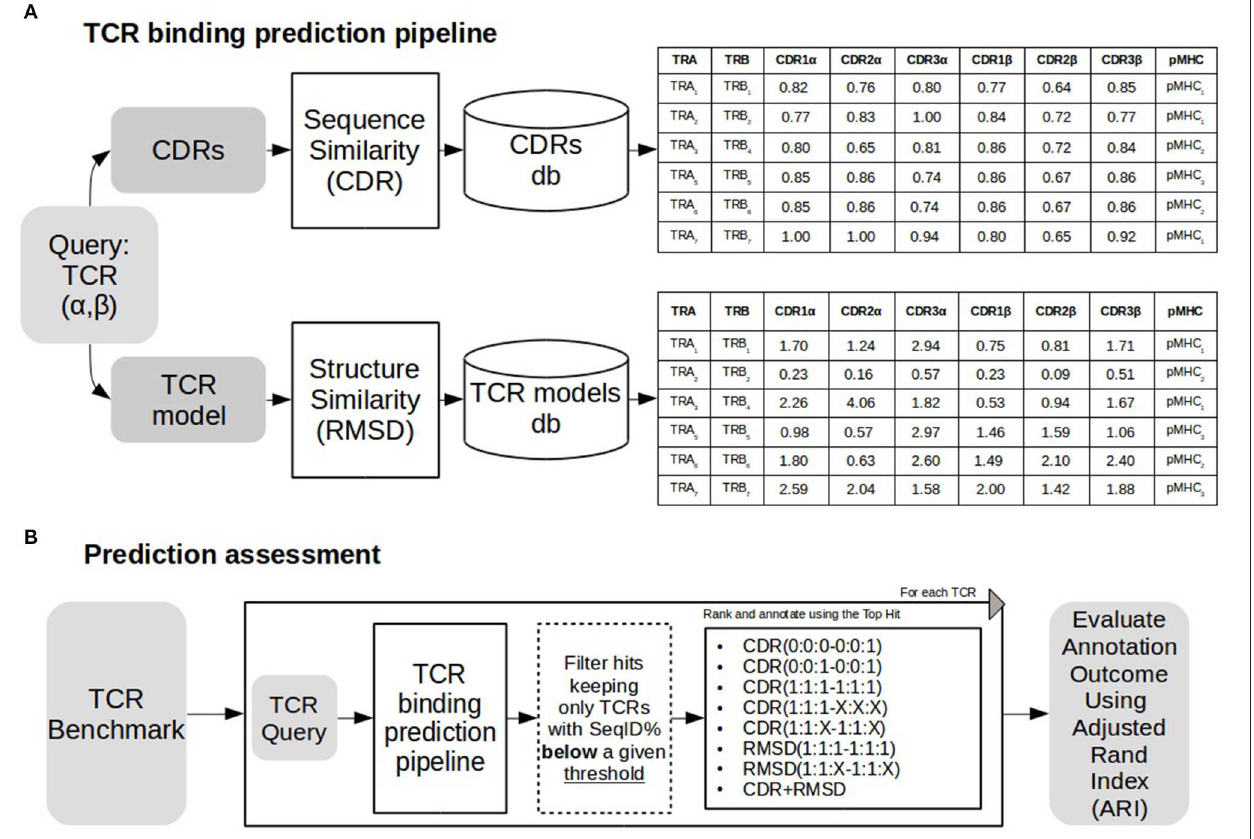
FIGURE 1 | TCR binding prediction and assessment. (A) TCR binding prediction pipeline using different similarities. A TCR query is searched against a database of CDRs of different TCRs. Similarities (CDR and RMSD) are calculated as described in methods. Sequence similarity values for each CDR loop are shown in the table above, and RMSD values for structural similarity are shown in the table below. (B) The prediction pipeline was assessed annotating each TCR removing TCRs sharing sequence similarity above a define threshold with the query. Both CDR and RMSD similarities were tested with different weights (for details see text). Performance was assessed using Adjusted Rand Index